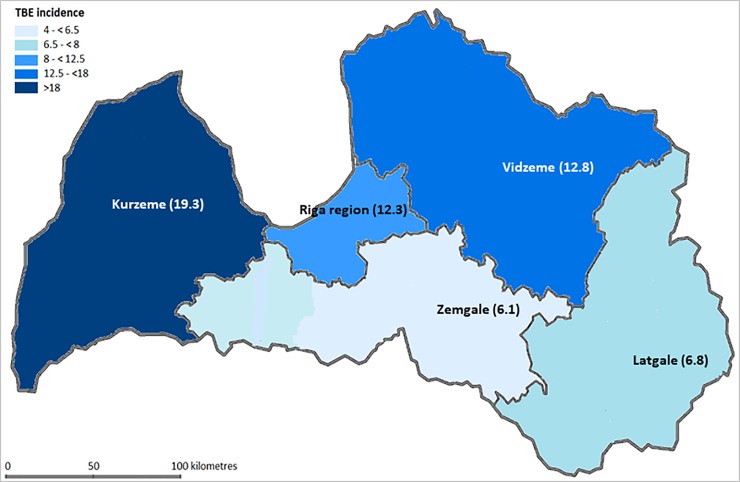
TBE average incidence rate per 100 000 inhabitants by regions of Latvia (period 2007–2016).